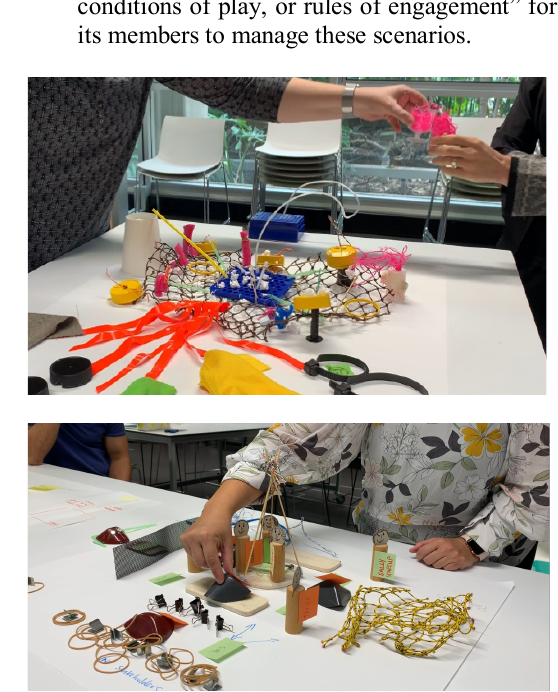
Fig. 2. Activity 2 Rich metaphors in the ARM Hub ecosystem